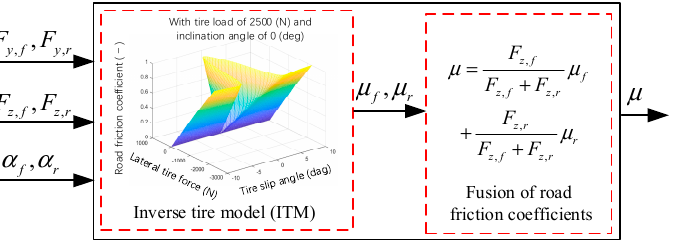
Figure 4. Schematic diagram of the ITM estimator.